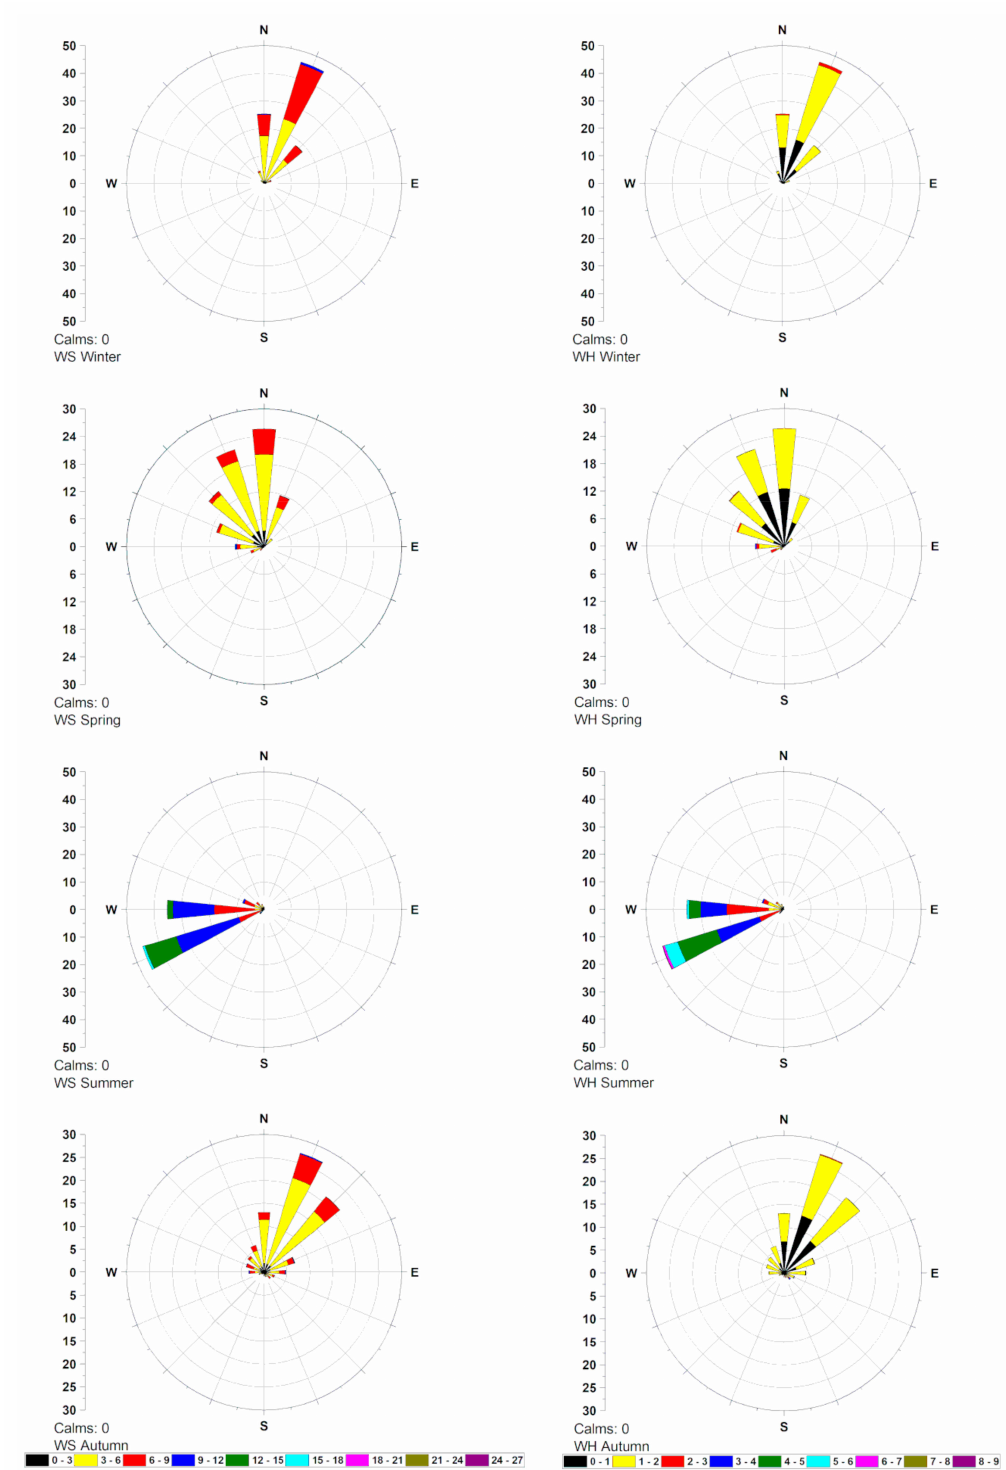
Figure 11. Post-encroachment (2011–2017) seasonal hydrodynamics of the Karachi (WS = wind speed, WH = wave